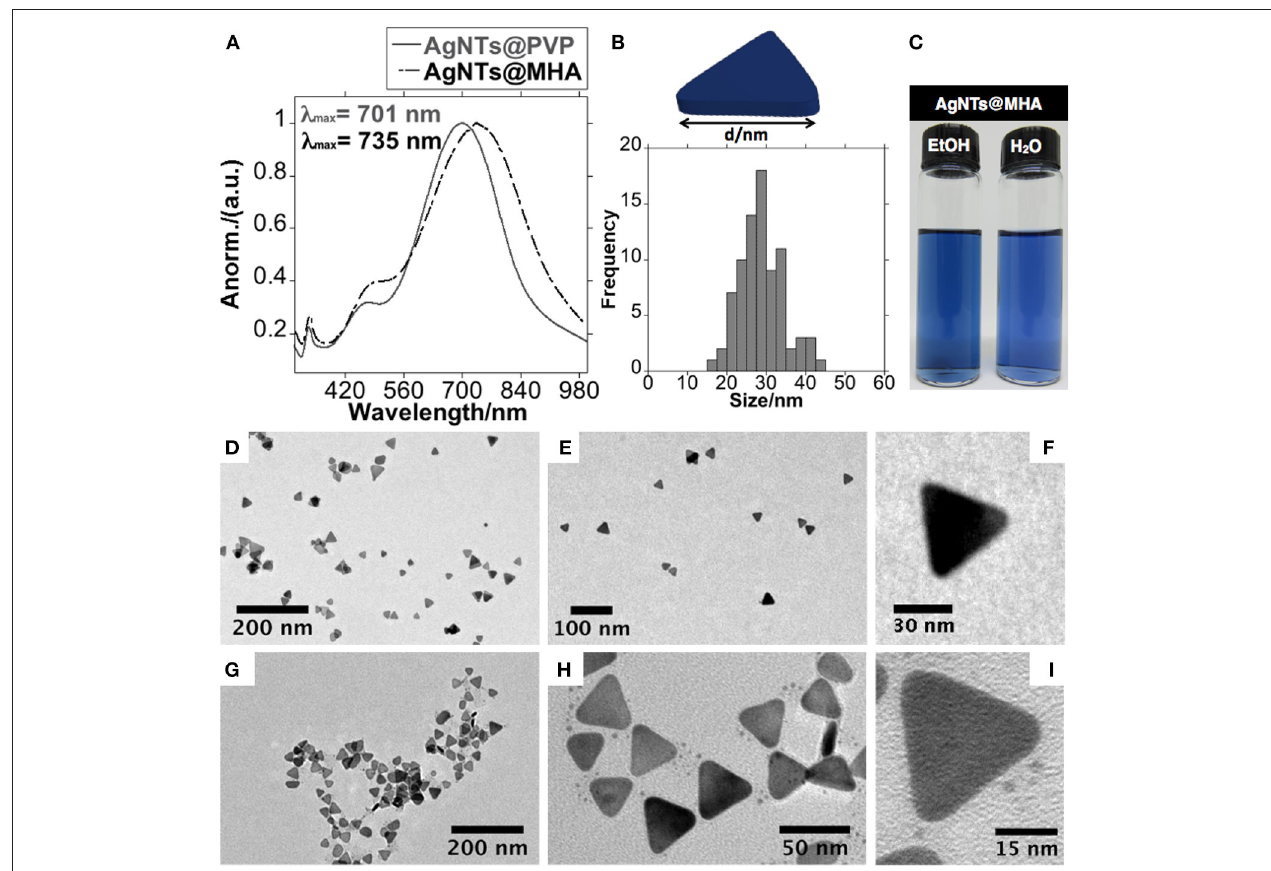
FIGURE 2 | Spectroscopic profile of AgNTs@PVP and AgNTs@MHA in EtOH solution (A) , size histogram of lateral distance of AgNTs@MHA (B) , color solution of AgNTs@MHA resuspended in EtOH and water (C) . TEM images obtained of AgNTs@PVP (D–F) and AgNTs@MHA (G–I) .